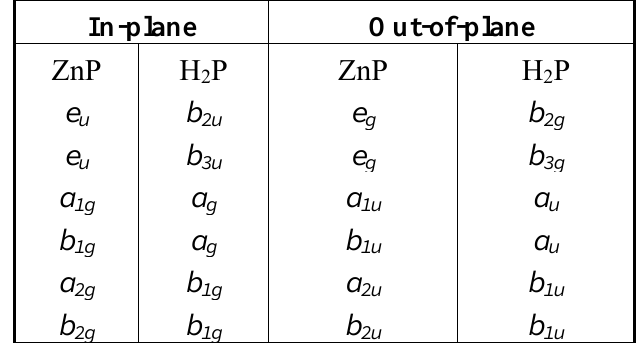
) and H P ( D ) 4h 2 2h